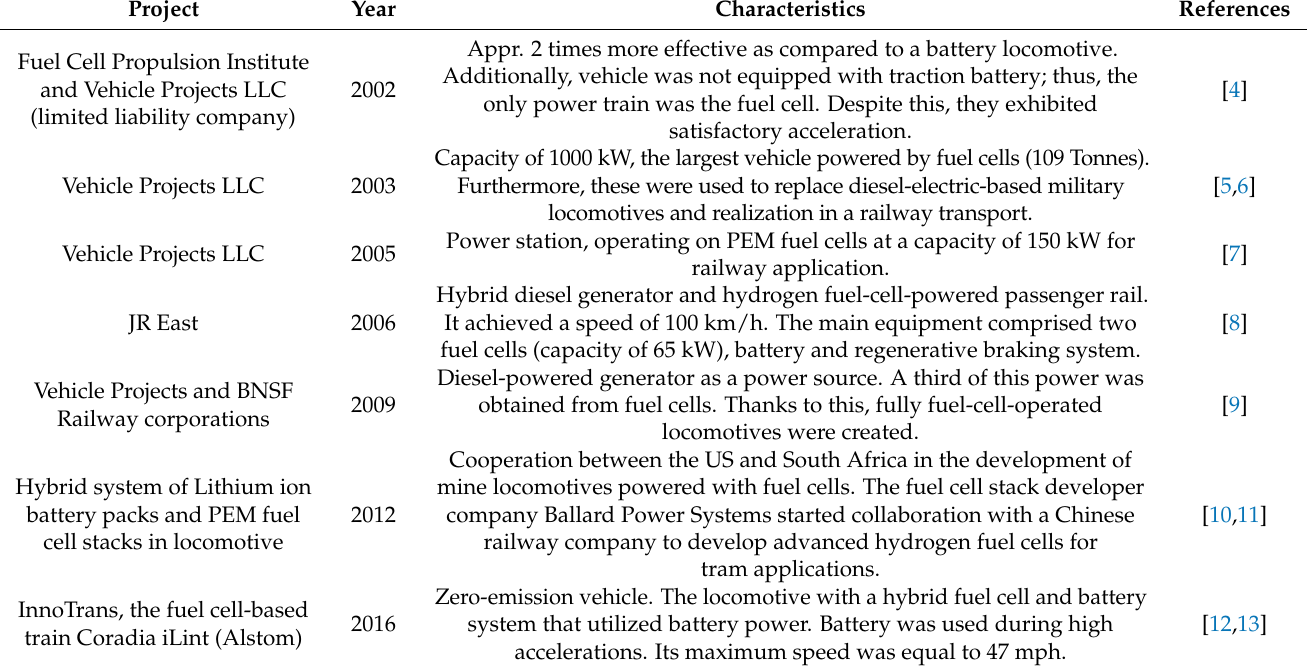
Table 1. Railroad